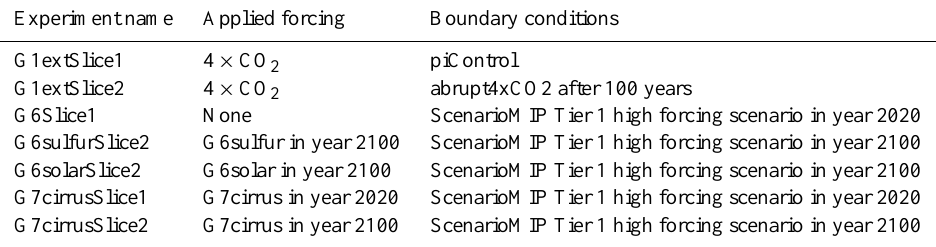
Table 2. Time-slice simulations associated with each of the four Tier 1 experiments. Further description of the time-slice simulations is given in Sect. 3.1. Each Tier 1 has two associated time-slice simulations: one for the beginning of the coupled simulation and one at the end of the coupled simulation. The first time-slice simulations for G6sulfur and G6solar are identical, as no geoengineering has been applied yet. As such, this simulation is simply called